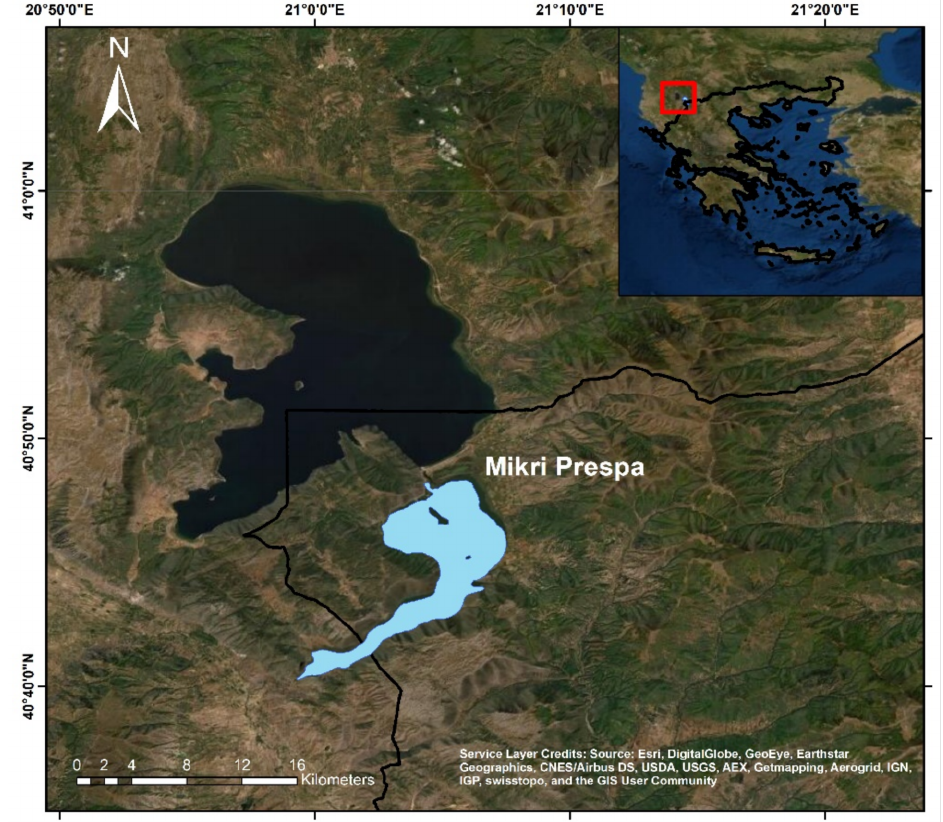
Figure 1. Map of the transboundary Mikri Prespa Lake located in northwestern Greece. Chlorophyll- a concentration and environmental data were collected from fifteen sam- pling sites on a seasonal basis from 2006 to 2008 (see Hadjisolomou et al. [19]). We used the following environmental parameters as predictors of chlorophyll- a (Chl- a ): pH, surface dissolved oxygen concentration (DO), electrical conductivity (EC), Secchi disk depth (SD), water depth (WD), surface water temperature (WT), total phosphorus concentration (TP) and dissolved inorganic nitrogen concentration